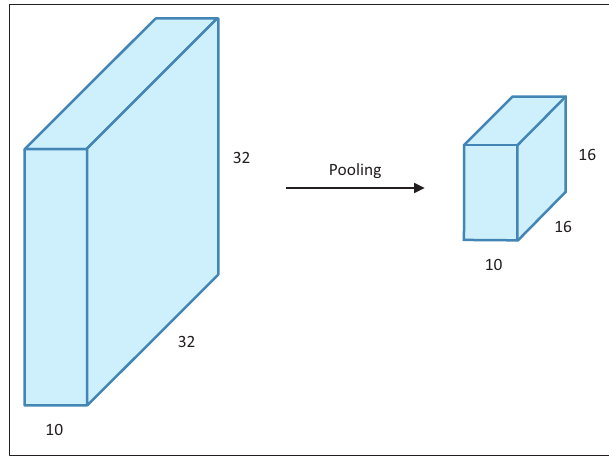
FIGURE 2: Convolutional Neural Network